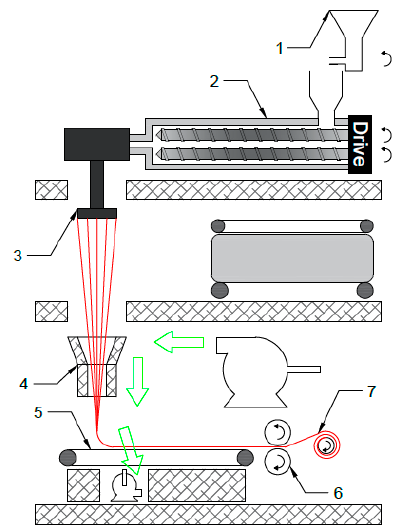
Figure 1. Schematic representation of a spunbond fibrillation system: (1) feeder, (2) twin screw extruder, (3) spinneret, (4) air drafter, (5) belt, (6) roller, (7) non-woven fiber mat.